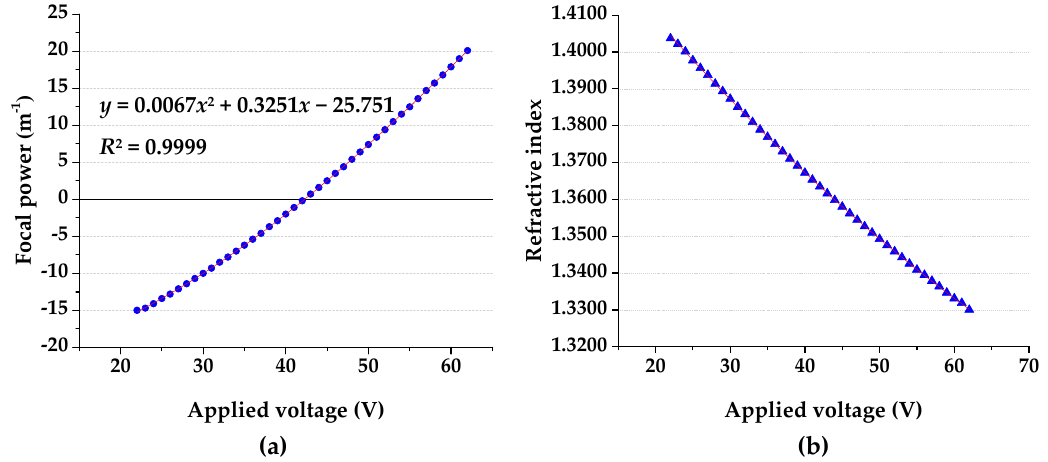
Figure 4. ( a ) Focal power of an electrowetting lens under different applied voltages. ( b ) Refractive index under different applied voltages.